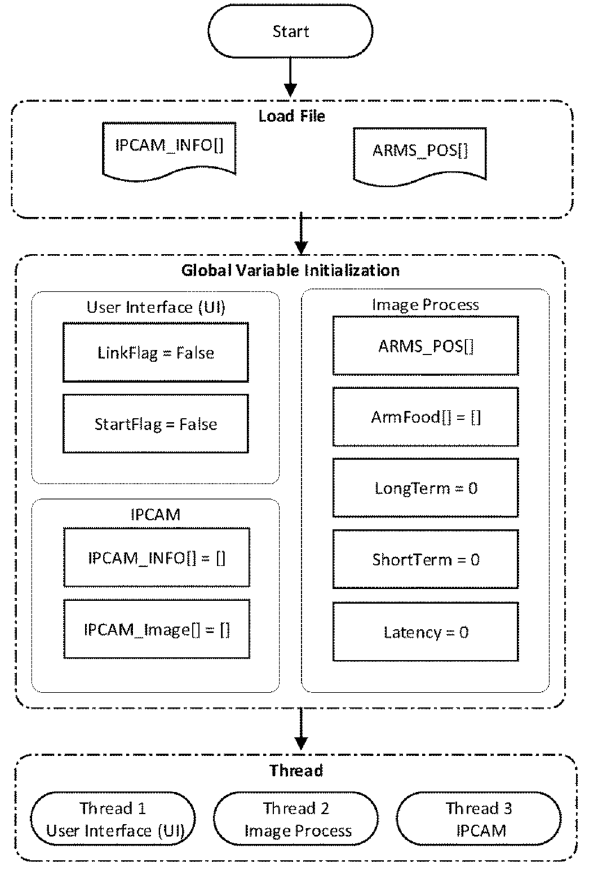
Figure 2. Software